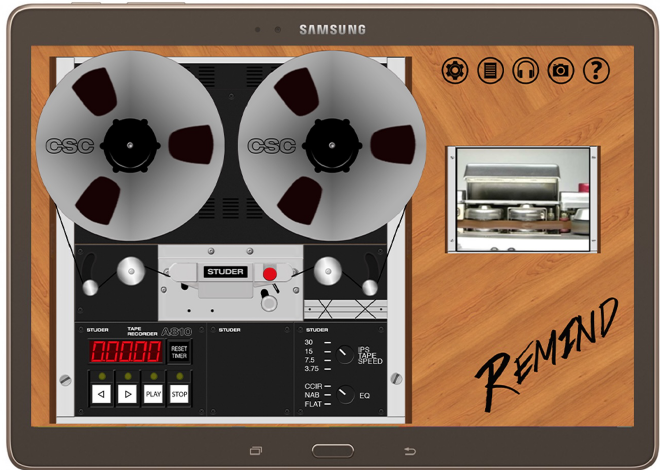
Figure 13. User interface of the REMIND app. A video of the original tape is shown separated from the tape recorder to improve